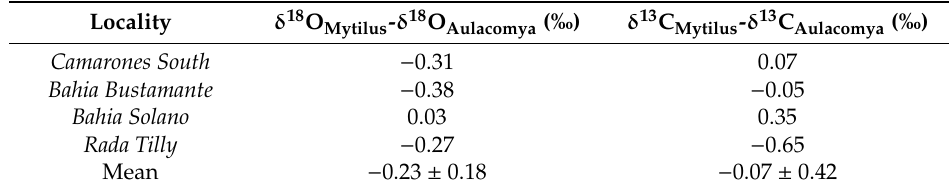
Table 5. Average isotopic di ff erences between Mytilus edulis and Aulacomya atra in di ff erent localities of